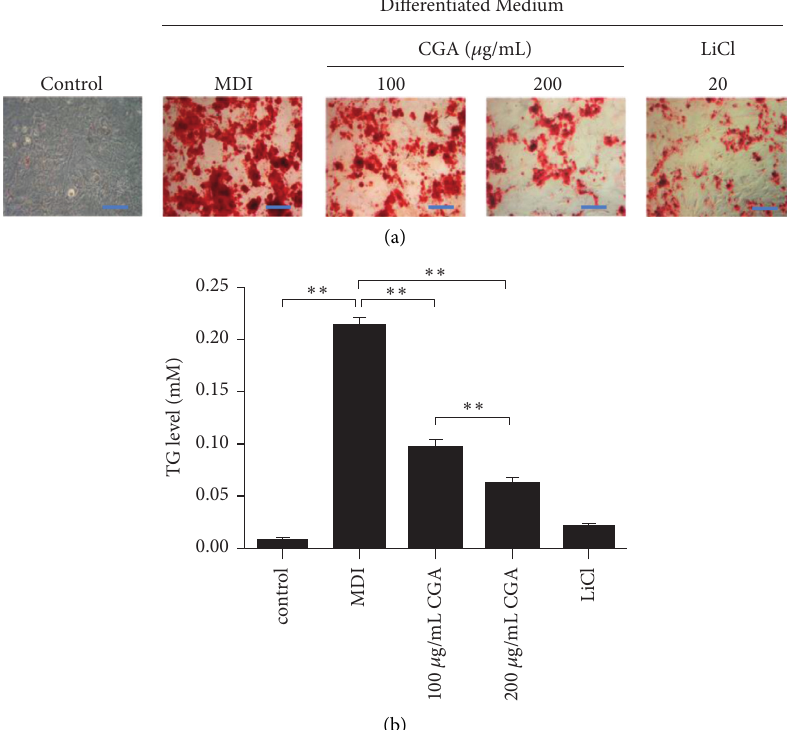
Figure 4: Effects of CGA on the adipogenesis of 3T3-L1 cells induced for 12 days. (a) Intracellular lipid droplets were stained with Oil Red O.Scale bar: 200 μ m. (b) Intracellular triglyceride concentrations. Data are presented as the mean ± SE from three independent experiments. ∗ P < 0 . 05, ∗∗ P < 0 . 01.